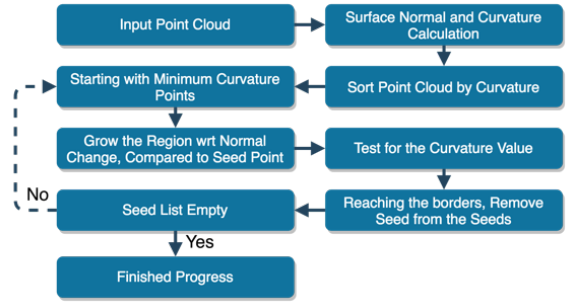
Figure 5. A brief summary of region growing algorithm.